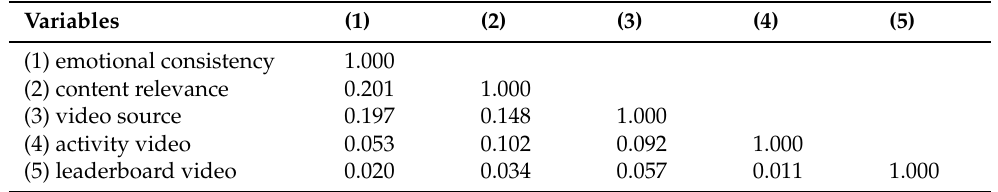
Table 3. Pairwise